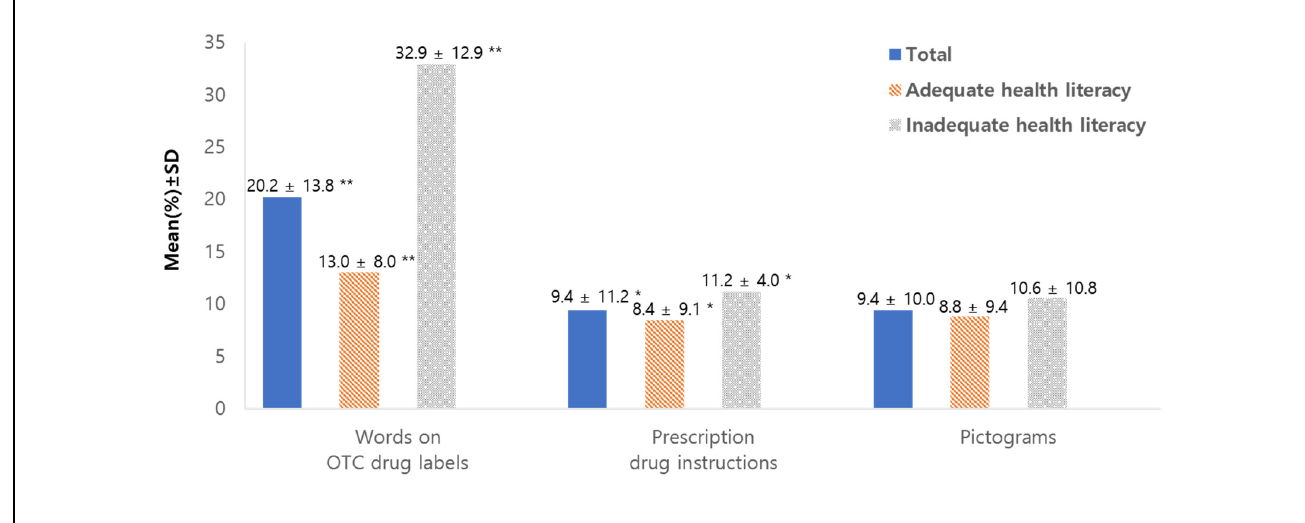
Figure 1. Level of misunderstanding of words on OTC drug labels, instructions for prescription drugs, and pictograms. p -value (* p < 0.05, ** p < 0.001) indicates statistical differences in each variable between adequate health literacy vs. inadequate health literacy groups. Abbreviations: OTC, over the counter; SD, standard deviation.